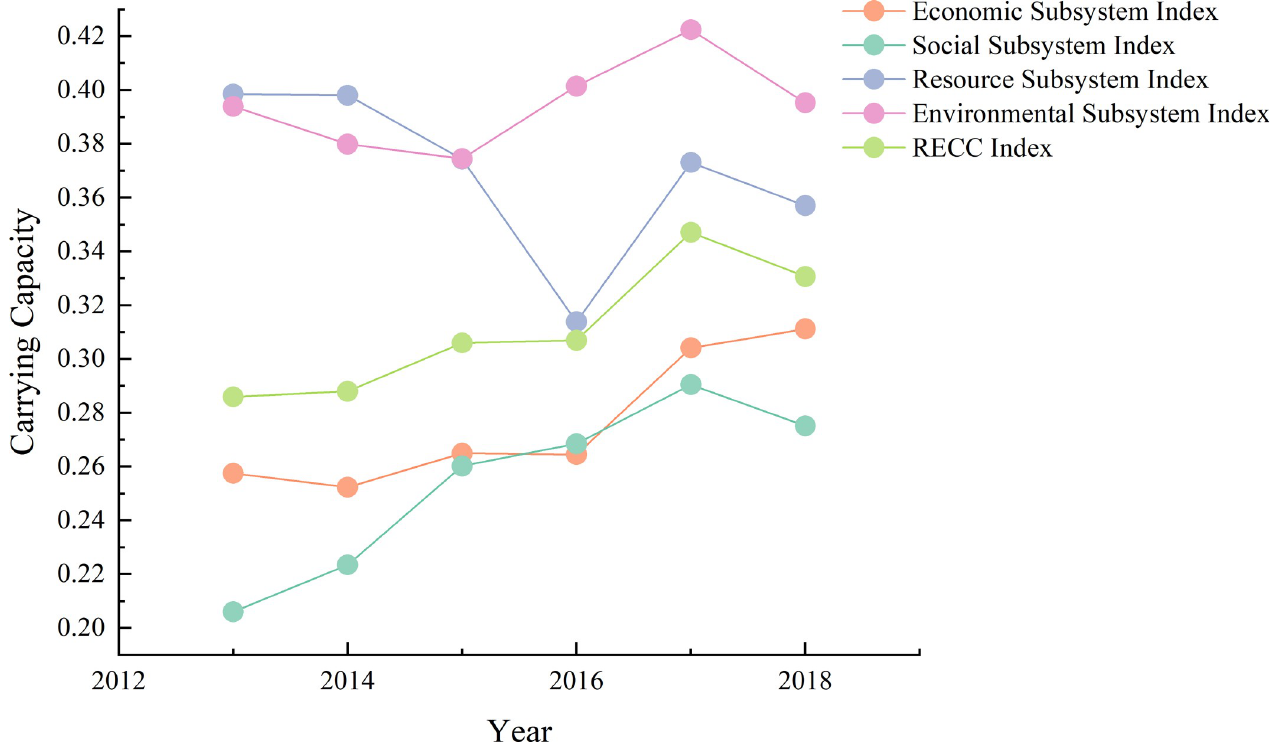
Fig 5. Average resource and environmental carrying capacity in 24 cities from 2013 to 2018.